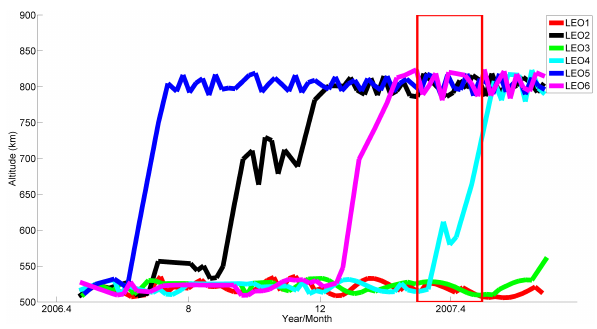
Figure 1. The altitude of each F3/C microsatellite from launch to middle of 2007. The red box indicates the time period of the